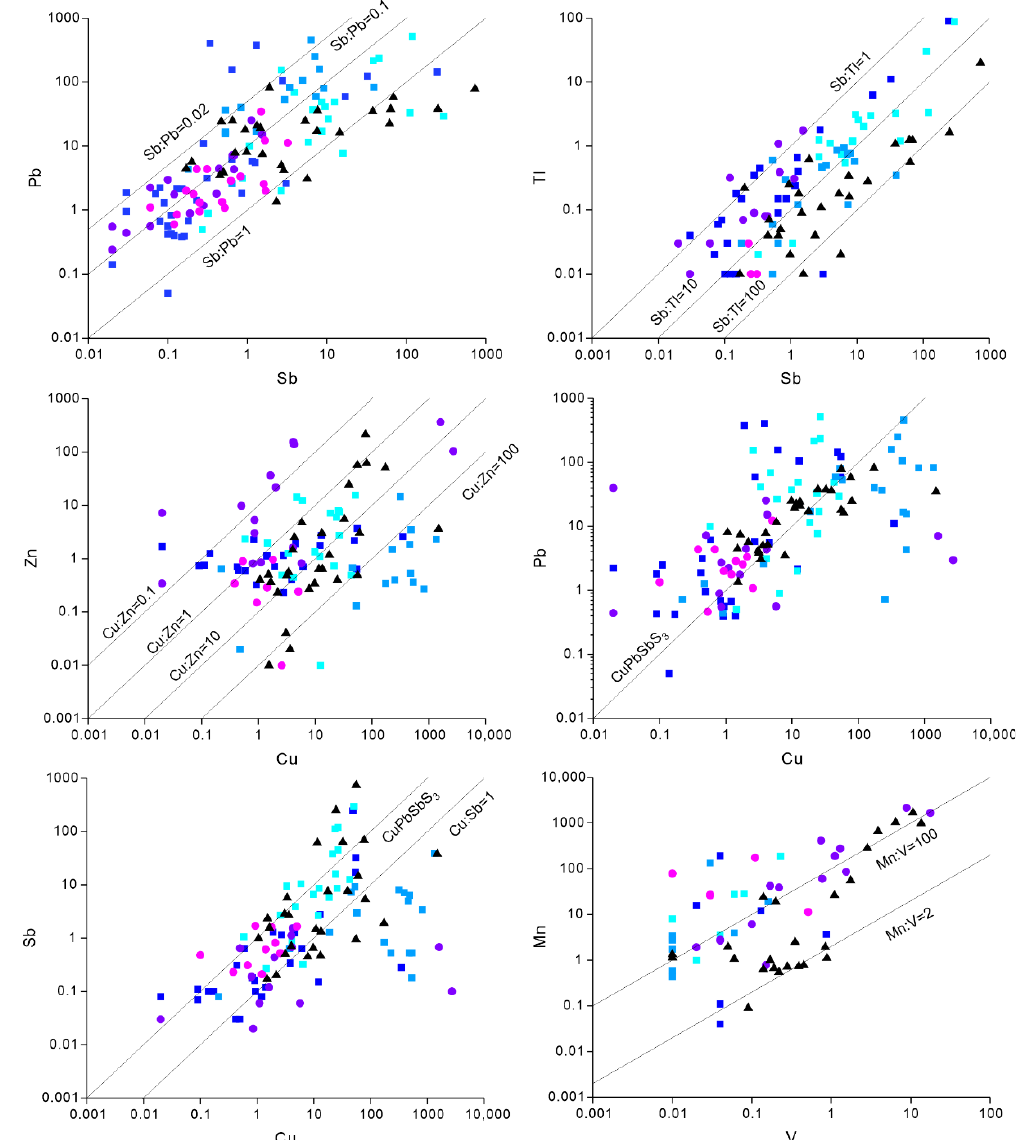
Figure 17. Binary plots of trace element in pyrites. Unit: ppm.